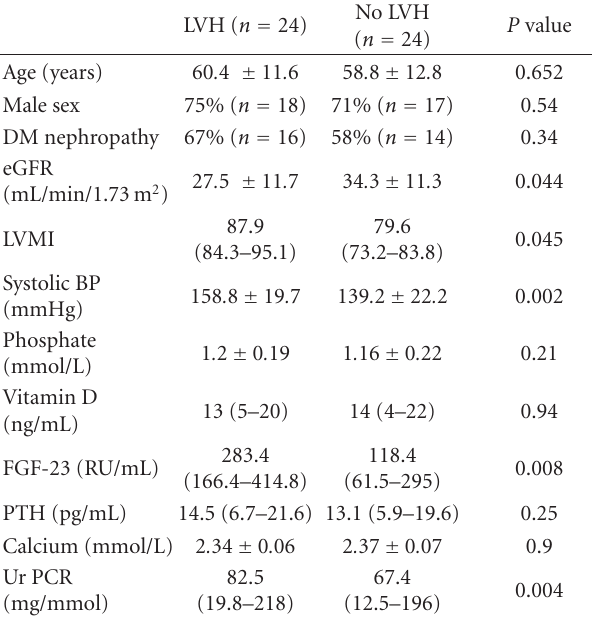
Table 2: Comparison between patients with CKD with and without LVH.